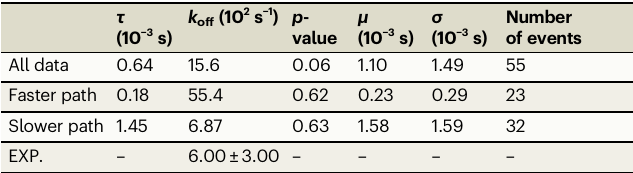
Table 2 | Ligand residence